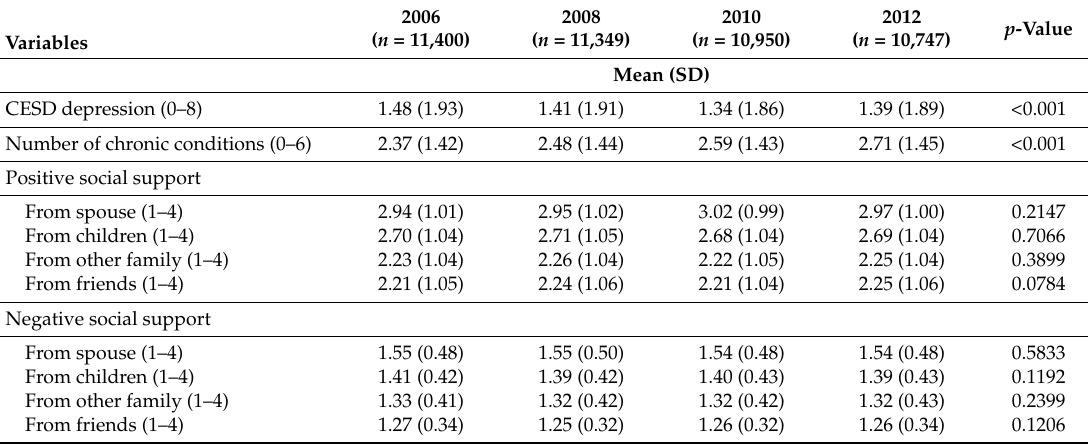
Table 1. Description of variables of interest by wave.